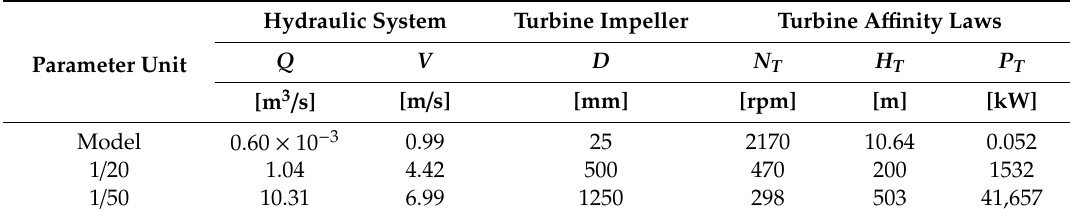
Table 4. Scale-up parameters for a hydraulic system and turbomachine a ffi nity characteristic parameters with n sT (in m, m 3 / s) =